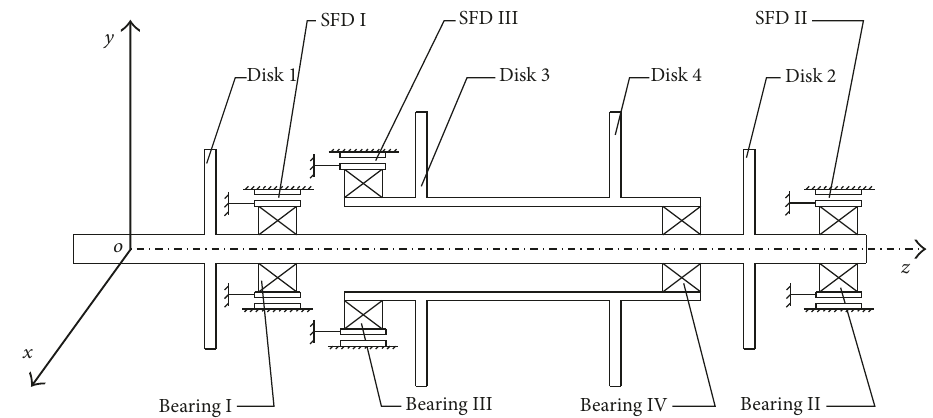
Figure 3: Structural diagram of the coaxial rotor system.